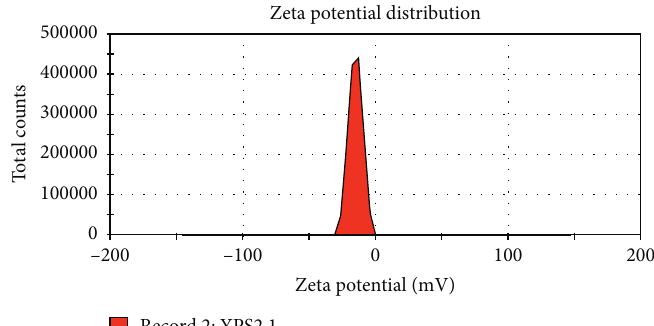
Figure 7: Zeta potential distribution diagram of the YPS2